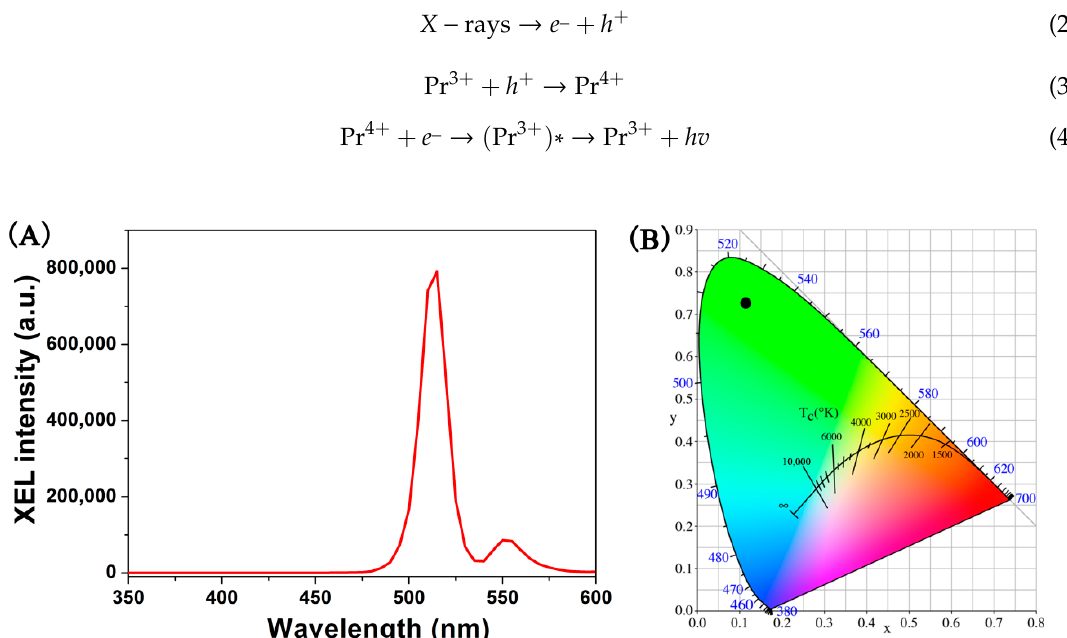
Figure 5. The relationship between log(I/c) and log(c) for the GOS:Pr phosphors.